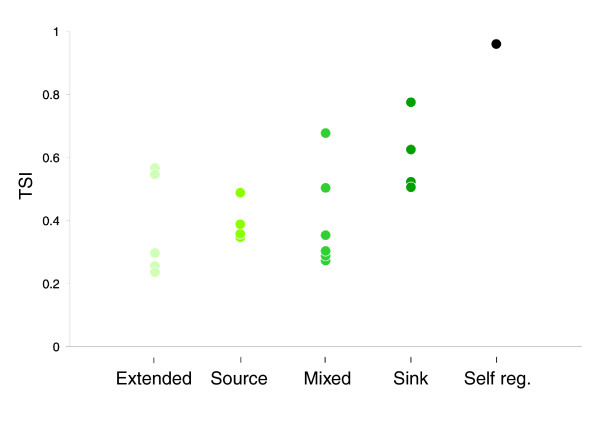
Tissue specificity of the SFs. The TSI of SFs grouped according to their positions in the network: 'extended', 'source', 'mixed', 'sink', and 'self-regulatory'. As shown, low tissue specificity is observed for the top layers while higher tissue specificity is characteristic of the bottom layers.